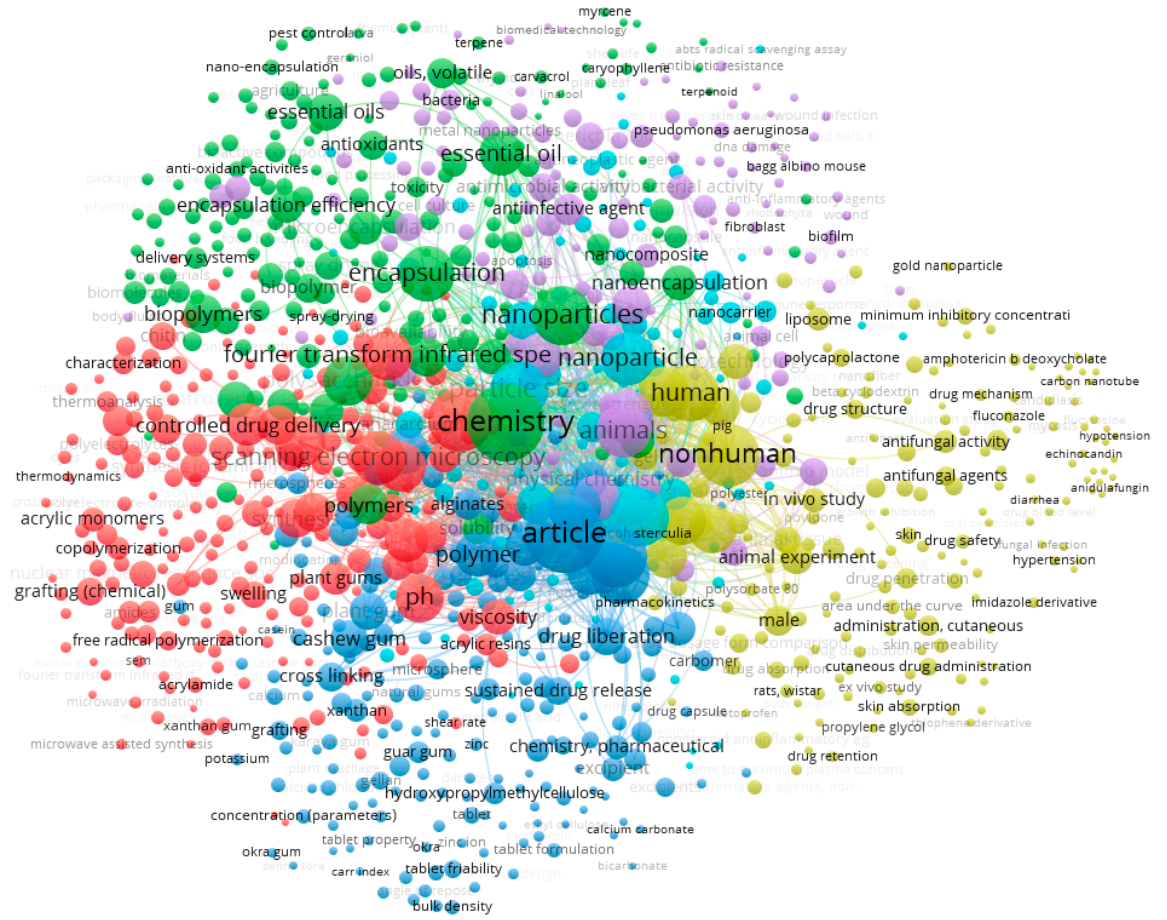
Figure 4. Bibliometric map obtained by VOSviewer software version 1.6.16 (https://www.vosviewer.com), using “cashew gum” AND “pharmaceutics” as keywords, recorded from Scopus database.